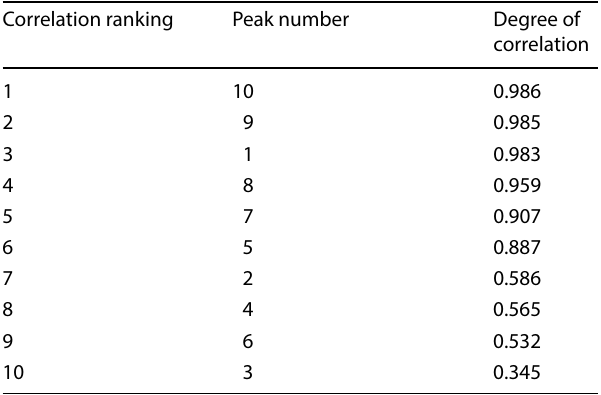
Table 4 Order of degrees of correlation between characteristic peaks and xanthine oxidase inhibition rates Correlation ranking Peak number Degree of